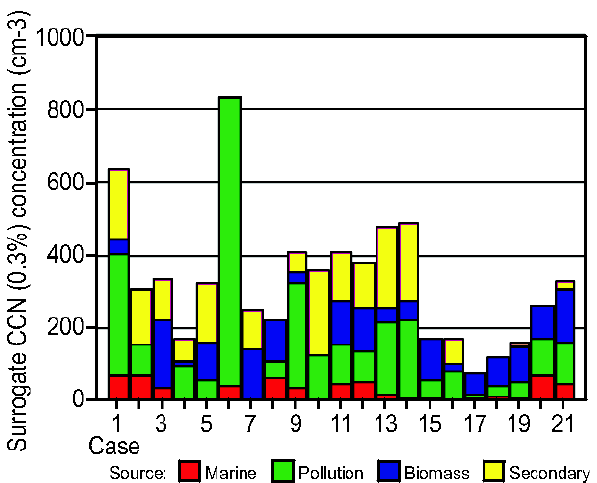
Figure 7. Source contributions to the surrogate CCN (0.3%) concentration of each of the four sources to each sample taken during the CARMA II study. The samples shown were taken consecutively between July 1 st and 21 st , 2004.